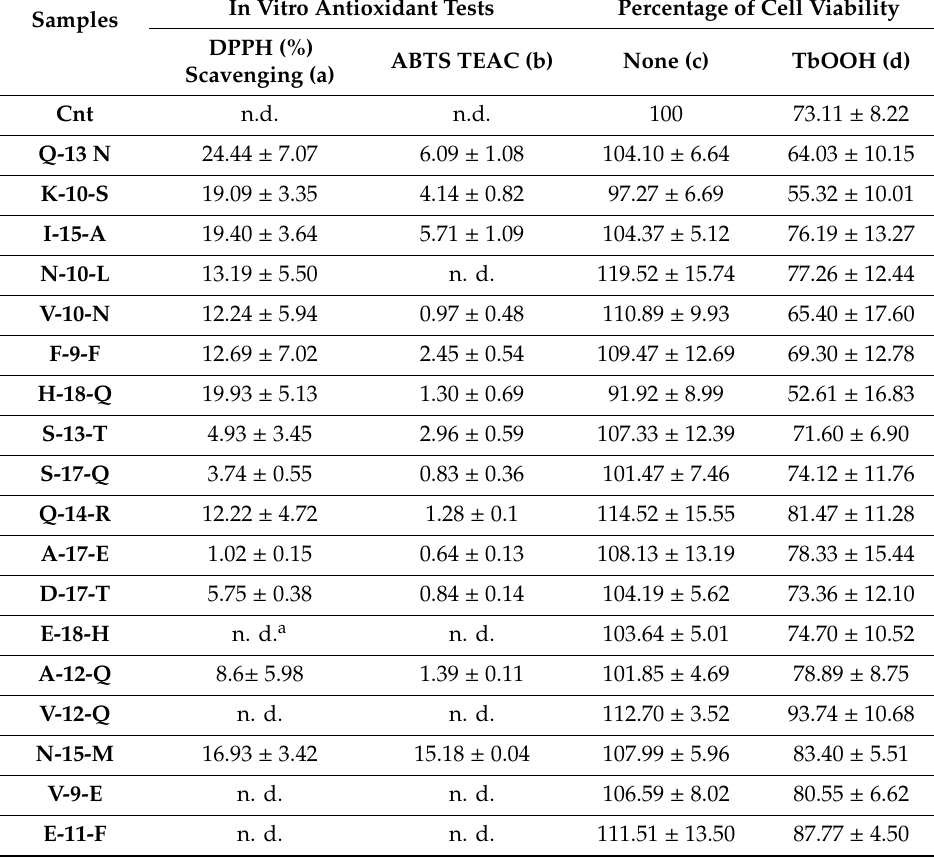
Evaluation of antioxidant properties of the identified peptides in vitro using 2,2 (cid:48) -azinobis(3-ethylbenzo-thiazoline 6-sulfonate) (ABTS) and 1,1-diphenyl-2-picrylhydrazyl (DPPH) scavenging tests and in Caco-2 cells pretreated with the 23 peptides. Oxidative stress was induced by 200 µ M